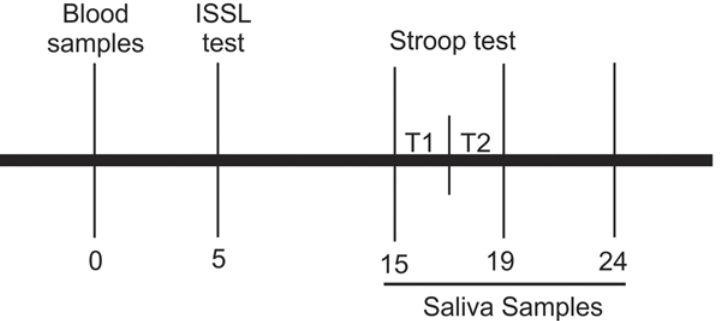
Fig 1. Experimental design. Numbers indicate time in minutes after the collection of blood sample. Stroop Color-Word Test is divided in two tasks, T1: Stroop Color task and T2: Stroop Color-Word task. ISSL test: Lipp Inventory of Stress